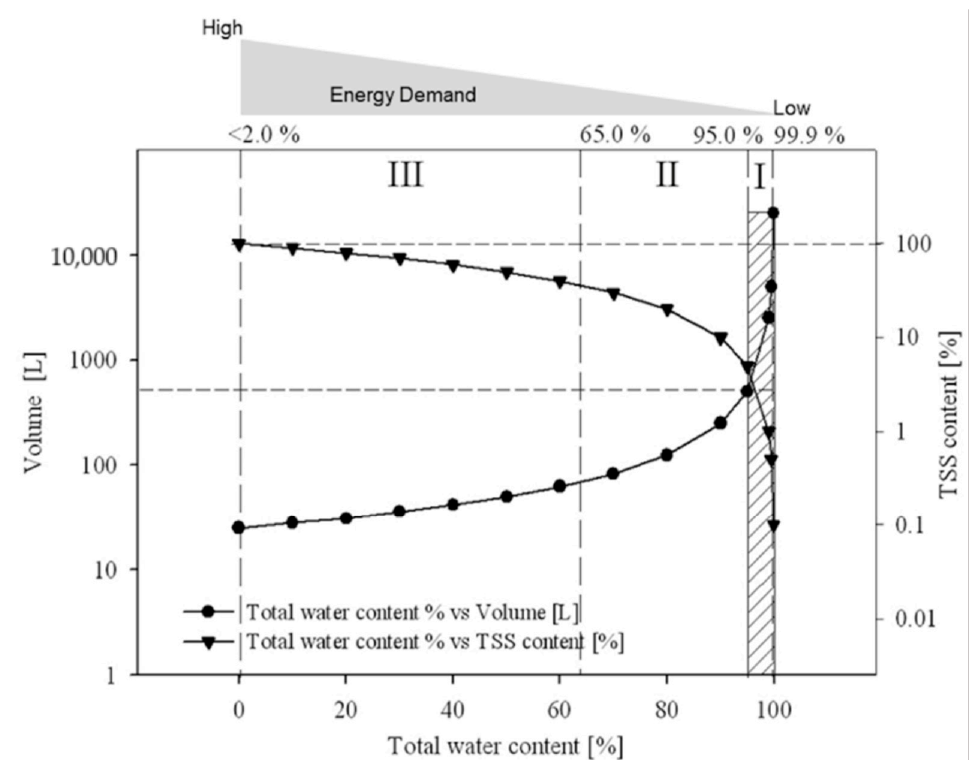
Figure 2. Relationship between volume and total suspended solids from harvesting of the determined volume algal culture, followed by thickening (I), dewatering (II), and drying (III), which was prepared based on the literature shown in Table